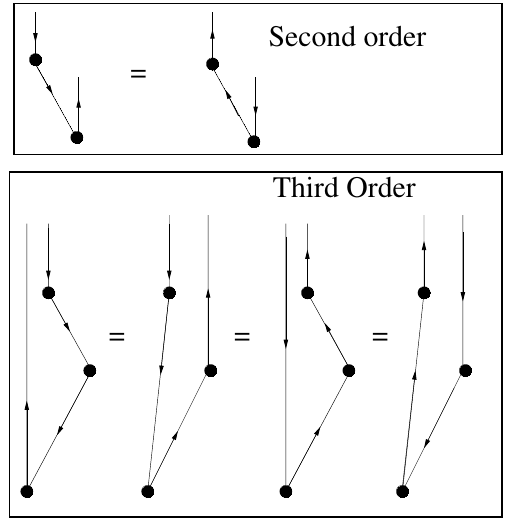
Figure A1. Schematic representation of the various types of paths involving forward and backscatter events for second- and third- order scattering.